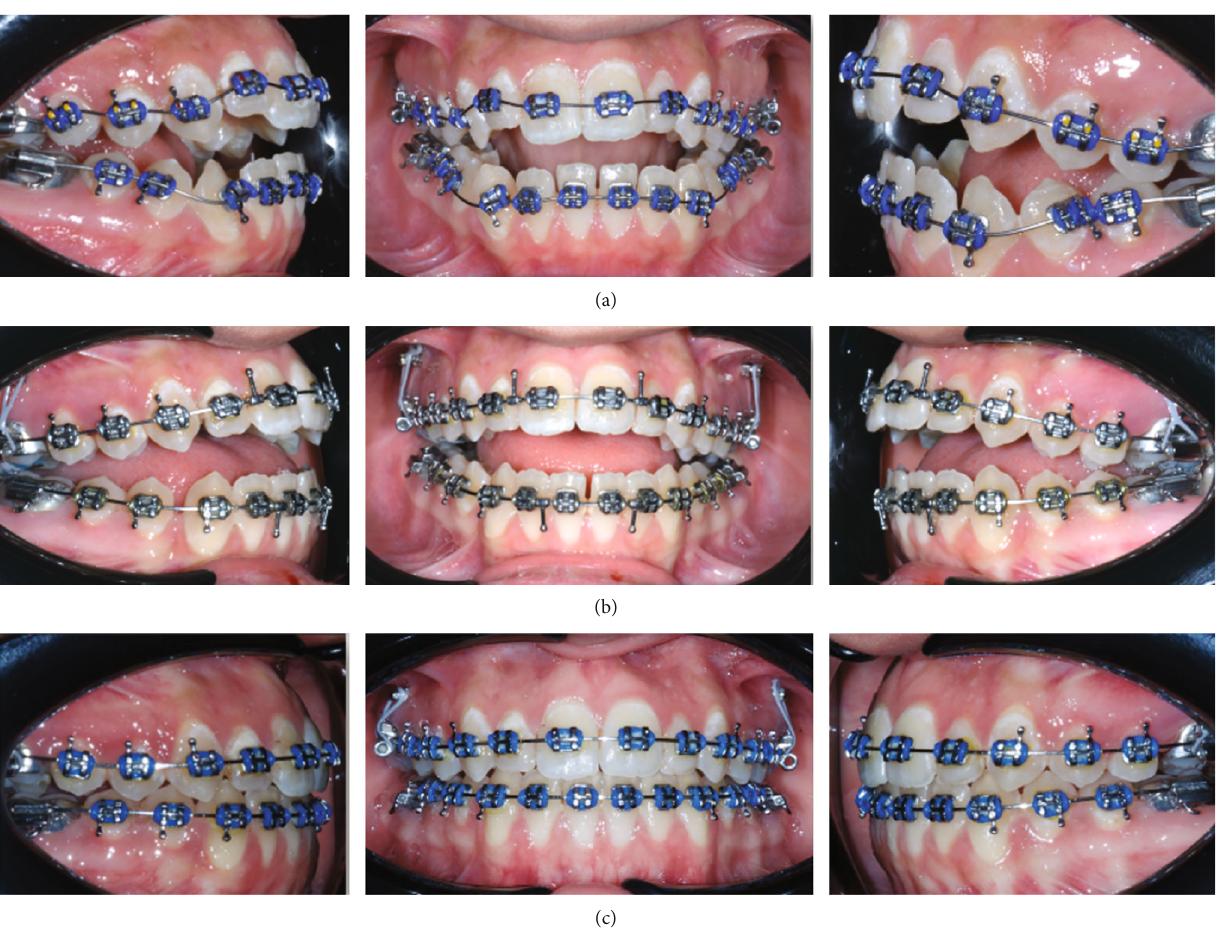
Figure 5: (a, b, and c) Progress